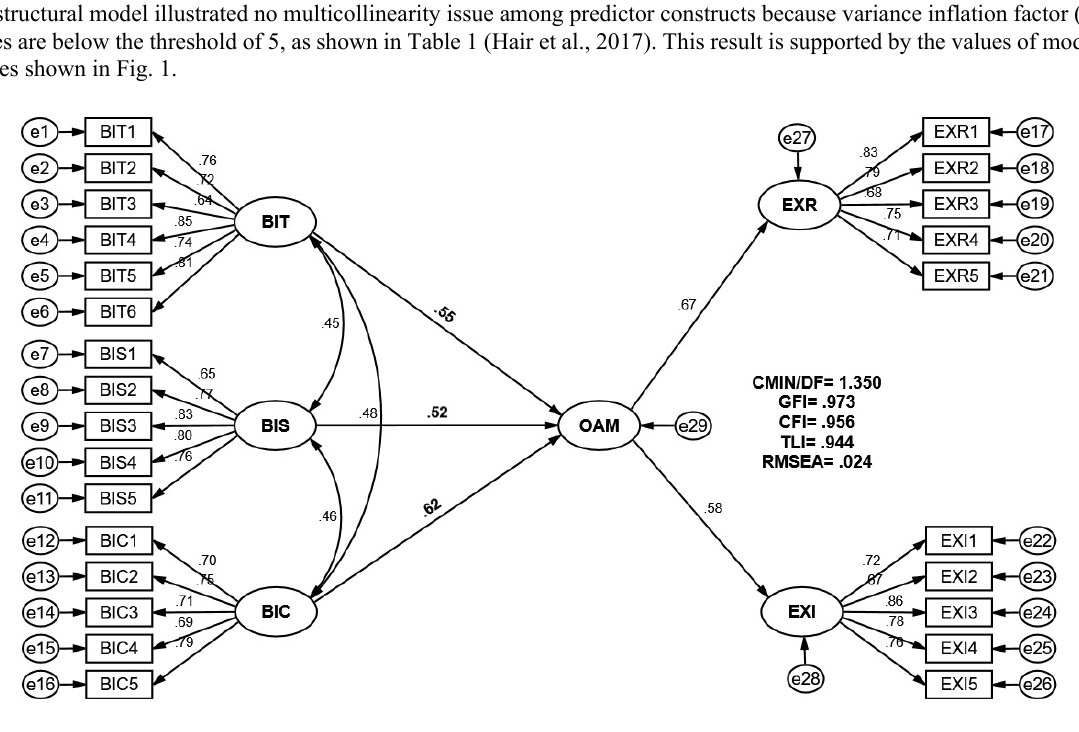
Fig. 2. SEM results of the digital marketing capabilities effect on organizational ambidexterity The results in Fig. 2 indicate that the chi-square to degrees of freedom (CMIN/DF) was 1.350, which is less than 3 the upper limit of this indicator. The values of the goodness of fit index (GFI), the comparative fit index (CFI), and the Tucker-Lewis index (TLI) were higher than the minimum accepted threshold of 0.90. Moreover, the result of root means square error of approximation (RMSEA) indicated to value 0.024, this value is a reasonable error of approximation because it is less than